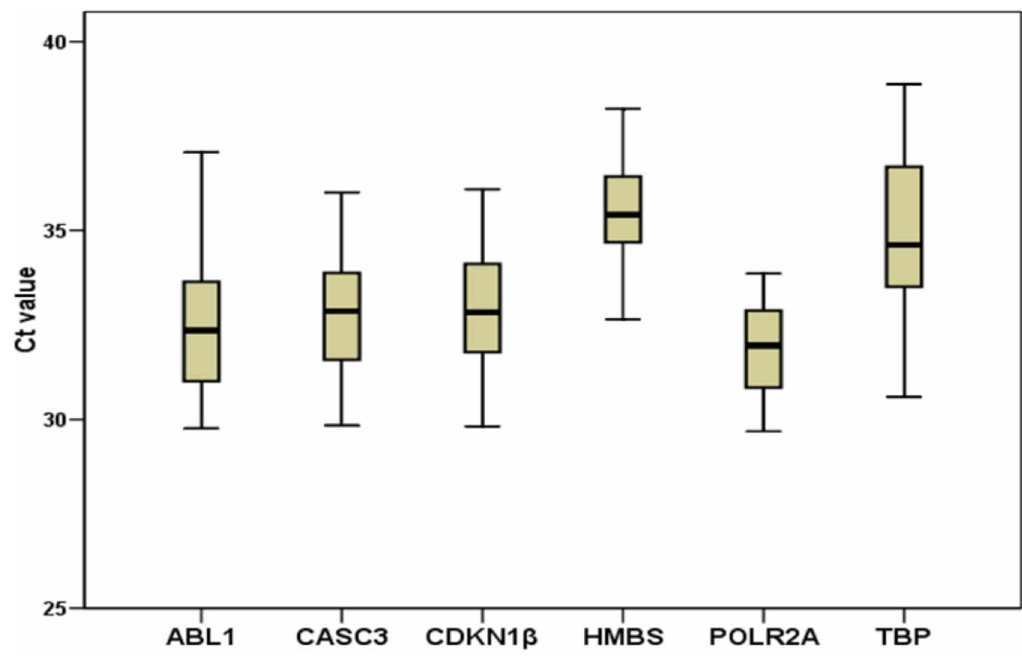
Figure 1. Expression levels of the six candidate reference genes.